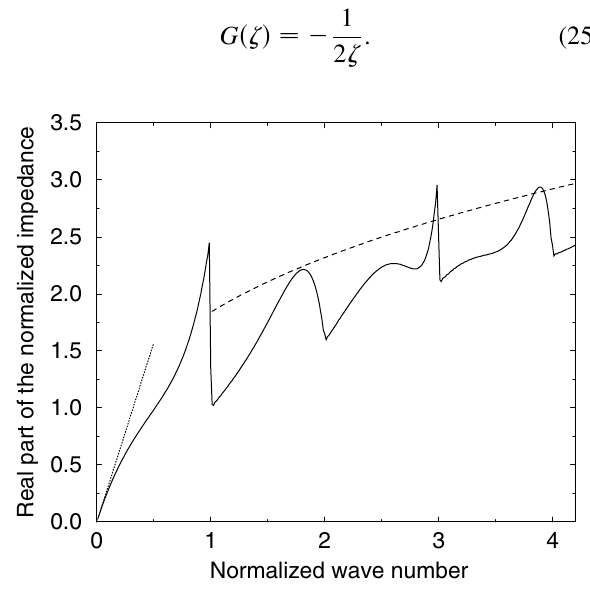
FIG. 5. The real part of the normalized impedance Z (cid:5) k (cid:6) =k as a function of the normalized wave number k=k numerical solution from Eq. (23); dotted line: analytical low- frequency asymptotic behavior from Eq. (26); and dashed line: analytical high-frequency asymptotic behavior from Eq.